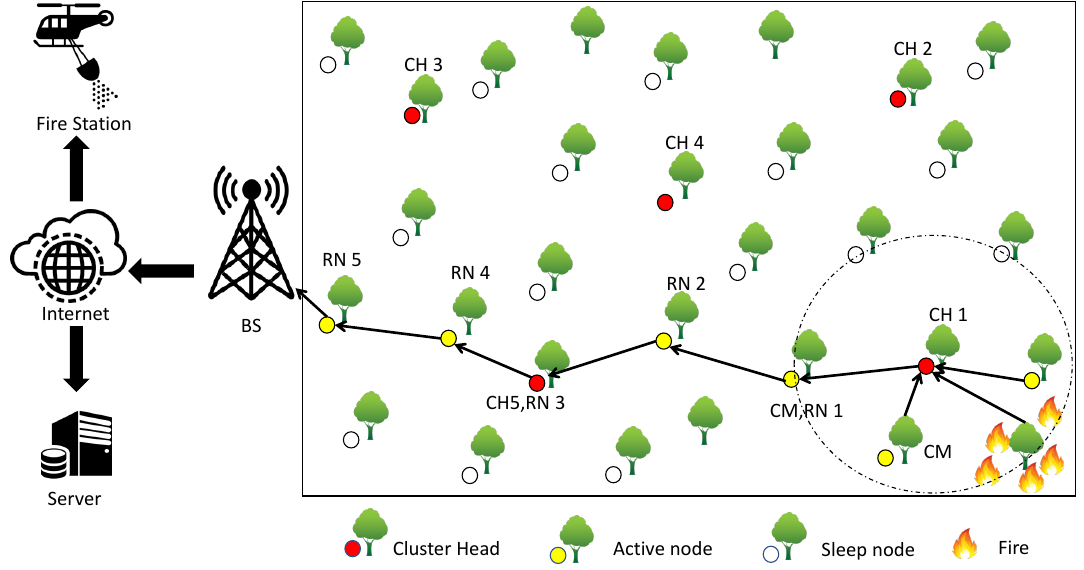
Figure 1. The network topology of a typical WSN network for disaster